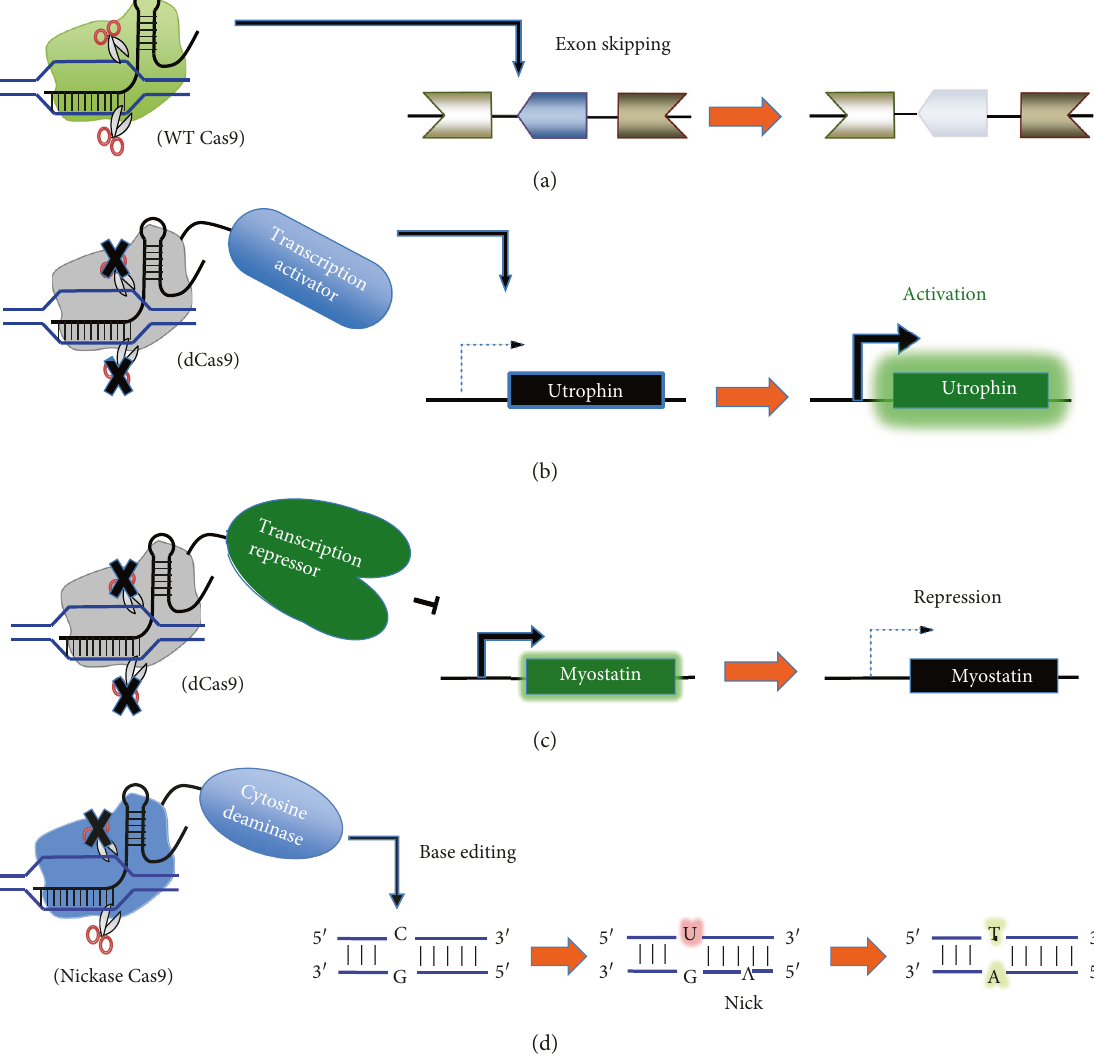
Figure 2: DSB and non-DSB mediated therapeutic approaches to potentially treat DMD. (a) WT Cas9 nuclease can be used to cleave DNA for exon skipping, frame shifting, or exon deletion as mentioned in Figure 1. (b) Catalytically inactive dCas9 fused with a transcription repressor such as KRAB can work as a sequence-dependent transcription repressor for a target gene such as myostatin to attenuate muscle wasting. (c) dCas9 fused with a transcription activator such as VP64 or p65 can work as a sequence-dependent transcription activator, in this case for activating utrophin expression to compensate for the absence of dystrophin. (d) Nickase Cas9 fused with a cytosine deaminase (i.e. APOBEC1 or AID homologue) can revert C to T by cytosine deamination. This can be used for correcting T → C mutations, or to disrupt premature stop codons or splicing acceptor sequences to induce exon